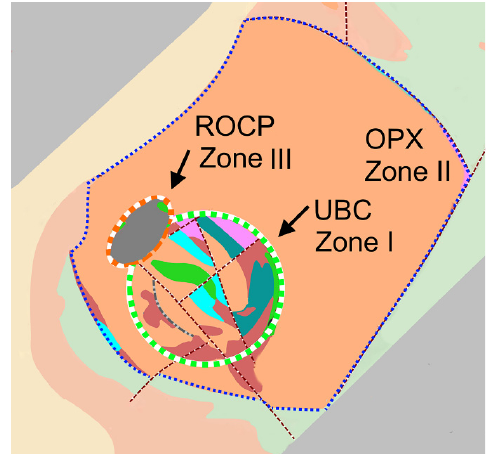
Figure 18. A generalized scheme of the geological structure of the Lyavaraka complex is based on our findings and results of previous mapping [16]. Three zones, shown schematically, are suggested: the Ultrabasic Core-like Zone (I), the Zone of Opx (II) and the Zone of Recurrent Ol + Cpx + Pl (III). See Table 1 for details. Table 1. Major structural units of the Lyavaraka ultrabasic intrusion.